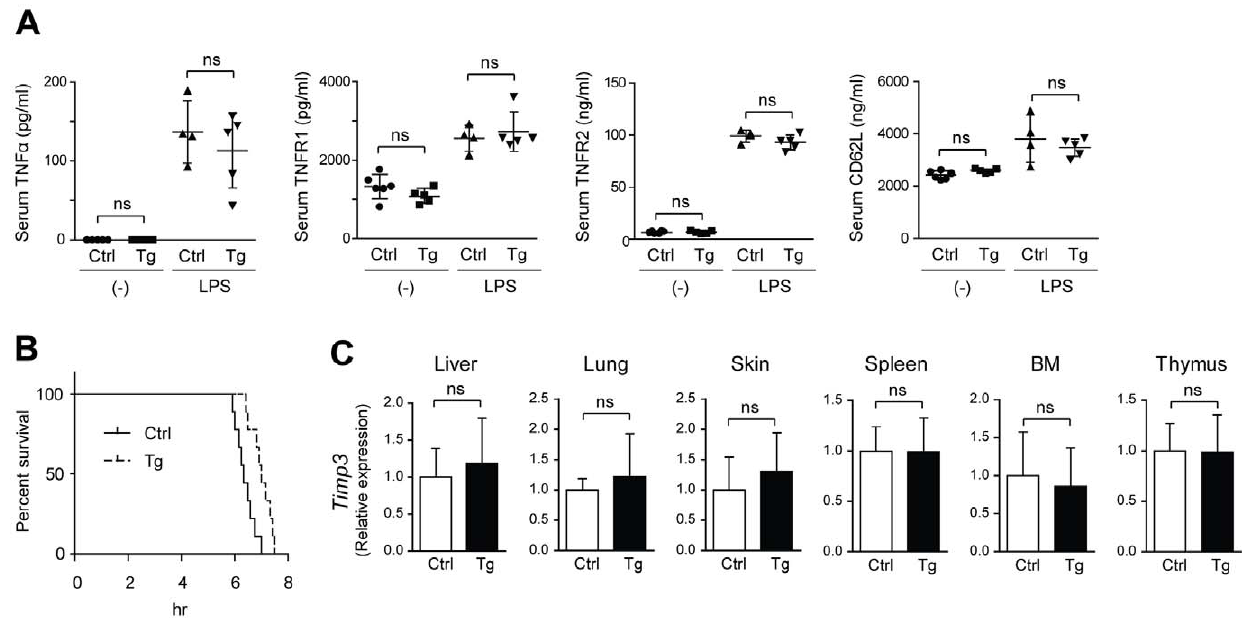
Figure 3. No apparent change in the serum levels of TACE substrates was observed in Tace -Tg mice. (A) The serum levels of TNF a , TNFR1, TNFR2, and CD62L were analyzed by ELISA in control and Tace -Tg (Tg) mice. The sera were collected under unchallenged conditions ( 2 ) or 3 h after the intraperitoneal injection of LPS and D-galactosamine. (B) Survival curve of the control (Ctrl) and Tace -Tg (Tg) mice treated with LPS and D-galactosamine ( n =18). (C) Quantitative RT-PCR of Timp3 in the liver, lung, skin, spleen, bone marrow cells (BM), and thymus collected from the control (Ctrl) and Tace -Tg mice. Bars, S.D. ns, not significant.